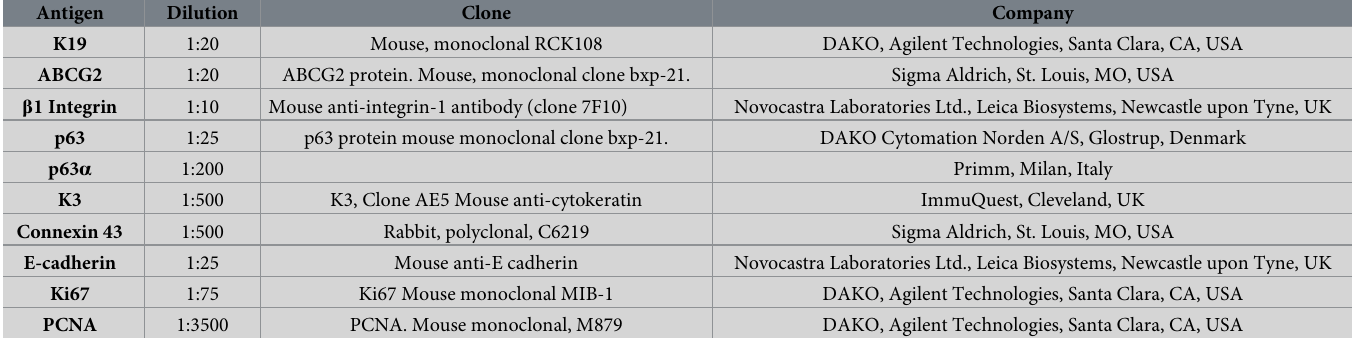
Table 1. Antibodies used in the present